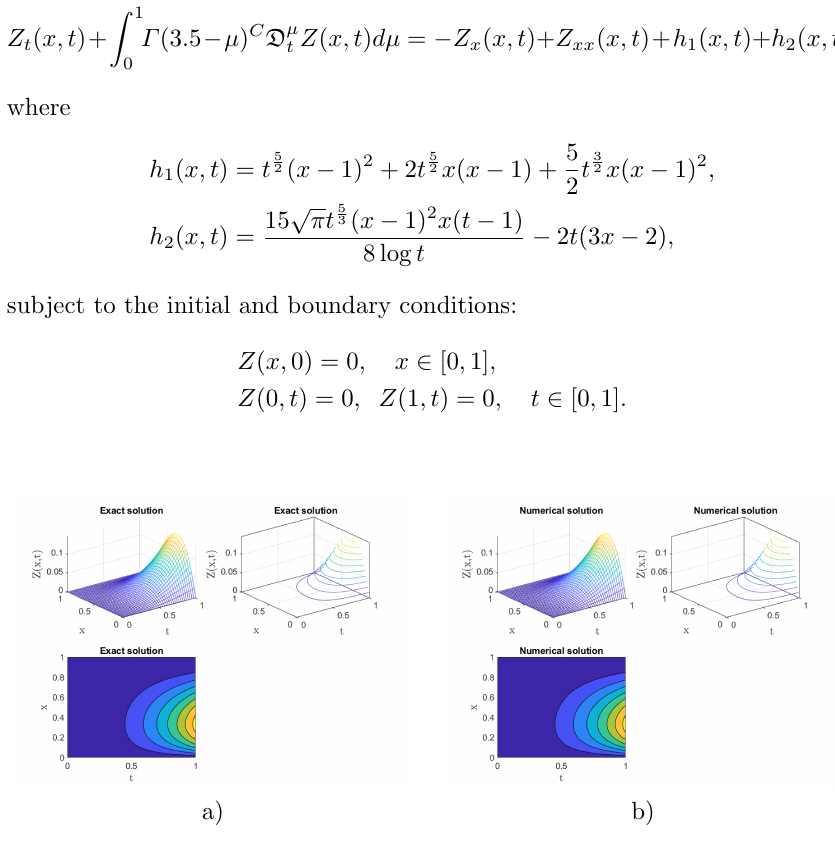
Figure 1. The exact solution ( a ) and approximate solution ( b ) with m = m ′ = 1, for Example M = M ′ = 4 and η = η 1 = 1 2